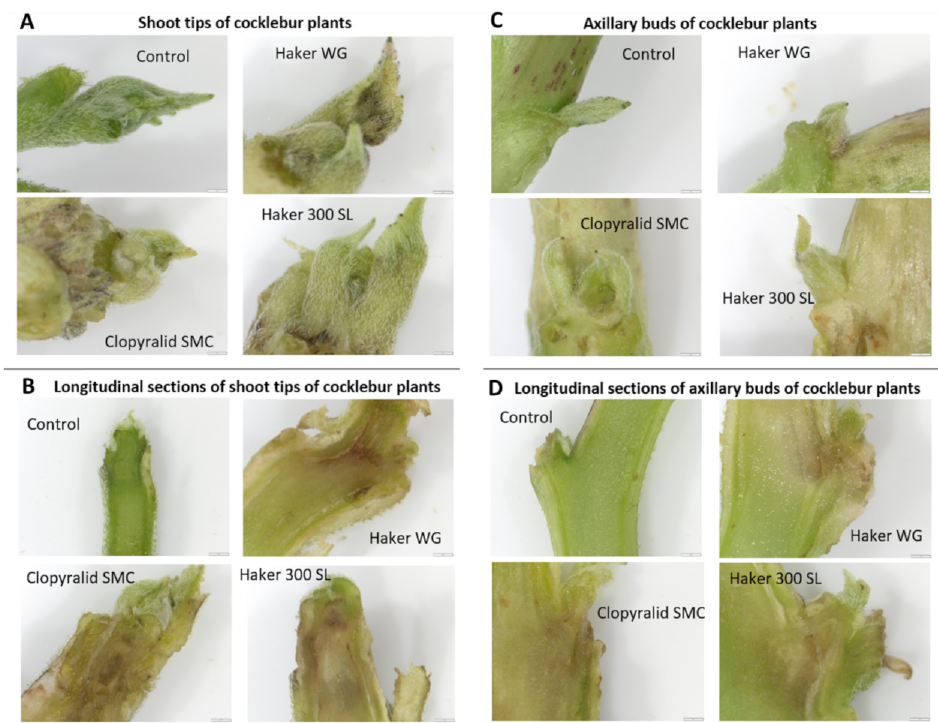
Figure 4. Characteristic abnormalities in cocklebur caused by clopyralid, observed on the 12–15th day after the herbicide application. ( A ) Shoot tips and ( B ) longitudinal sections thereof; ( C ) axillary buds and ( D ) longitudinal sections thereof. For each treatment, a series of images of nine randomly selected plants was made, the images were visually (by eye) ranked from the smallest damage to the largest, and the middle (fifth) image from each series was used for this